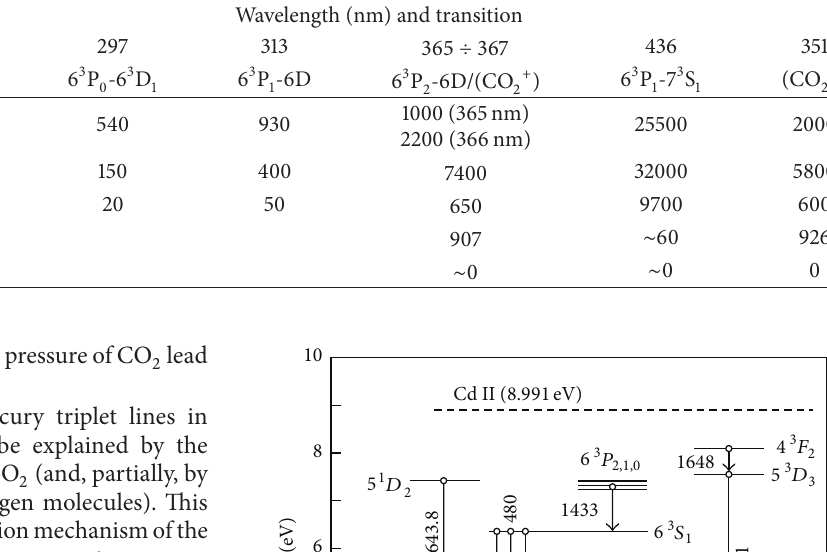
Table 1: Relative line intensities in mixtures containing mercury.